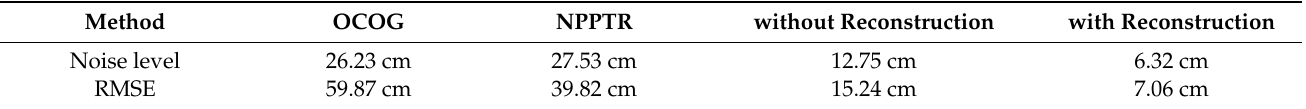
Table 4. Noise level and RMSE results of the SSH data retrieved by different methods.